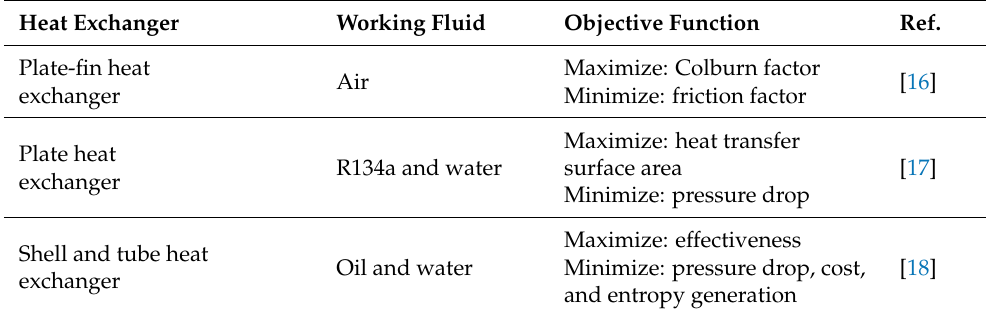
Table 1. Major studies for the flow channel optimization of PEMFC and the employed